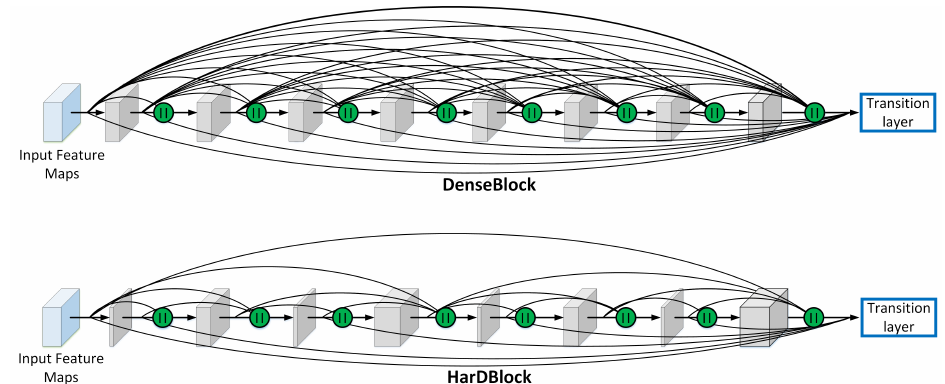
Figure 2. Concatenation scheme comparison between the DenseBlock and the HarDBlock. The HarD- Block is named after the harmonic wave patterns that describe its concatenation scheme. “ || ” denotes concatenation